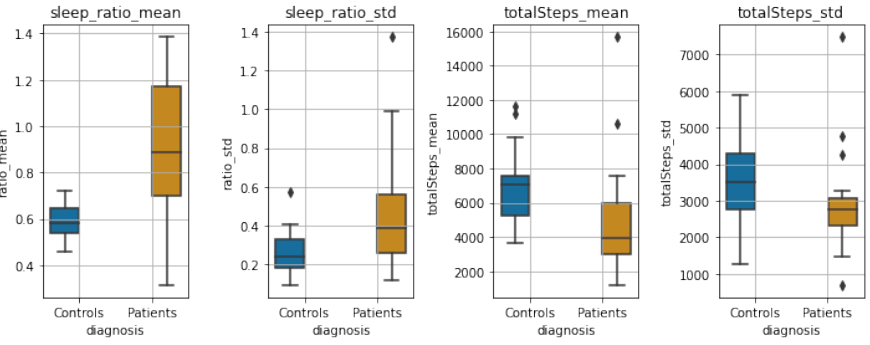
Figure 10. Boxplots of sleep/wake ratio and steps per day